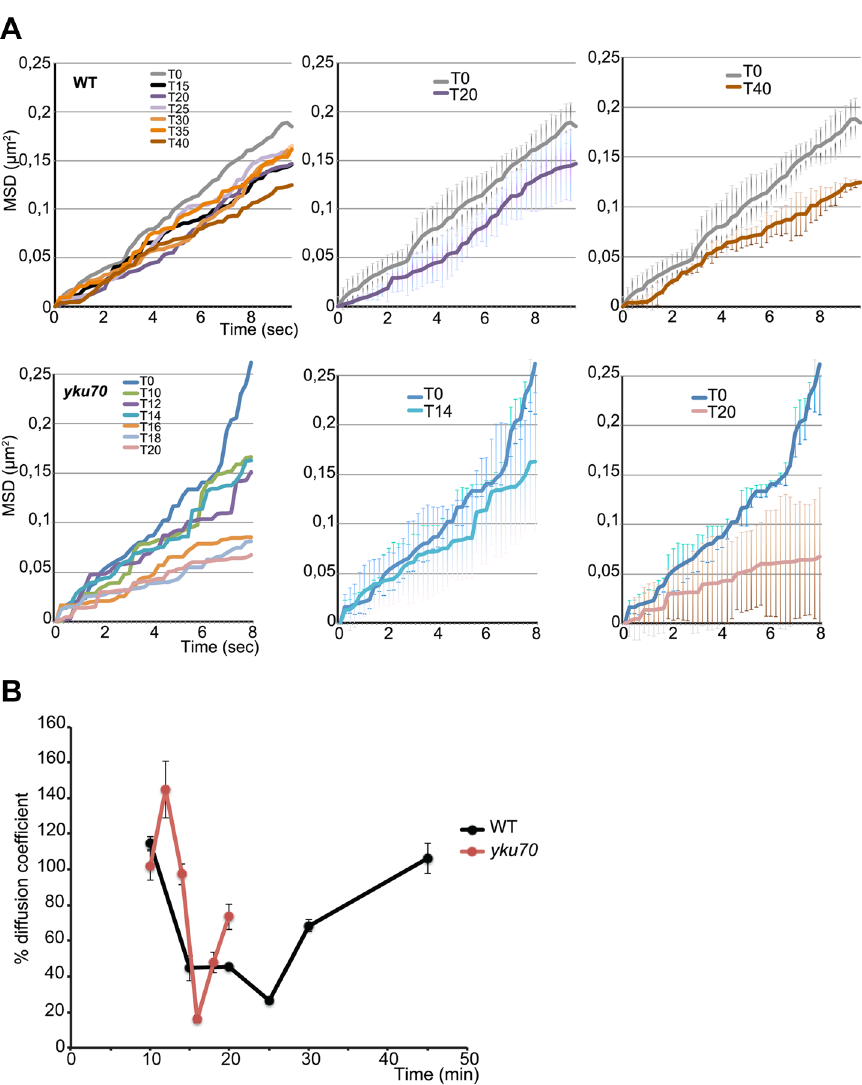
Figure 4. Time lapse microscopy of chromatin dynamics during resection. 2D stacks (50 6 200 ms frames) of the ParB2-GFP focus were acquired in wt and yku strains in which the ParB1-mCherry spot was lost, starting at 8 minutes post-addition of galactose to the medium. A . Mean- square displacement (MSD) for wt (n=12) and yku (n=3) cells of the uncleaved locus (black line) and at the indicated times after HO induction. B . Diffusion coefficients (D) for wt (black) and yku (red) calculated from the slope of the first 2 sec of the MSD shown in A and normalized to the average D=1.9 6 10-2 m m2/sec for uncut DNA set at 100%.